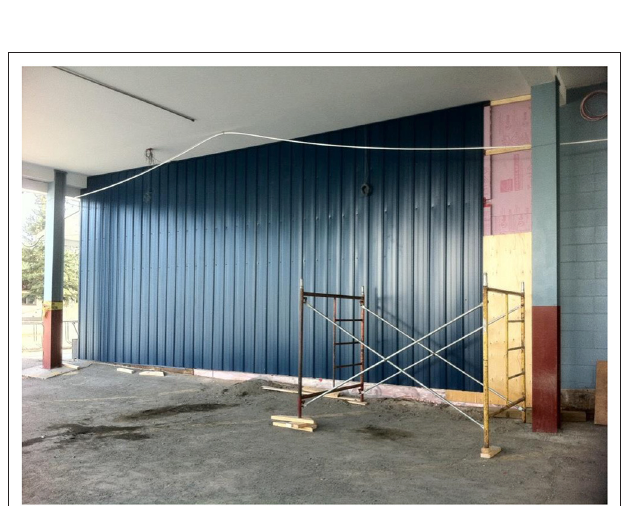
FIGURE 5 | Post-retrofit wall (MacLean and Korn, 2011). Because all holes for fasteners were drilled before the siding was put on the wall, it was possible to visually check that all fastening points were directly over the support